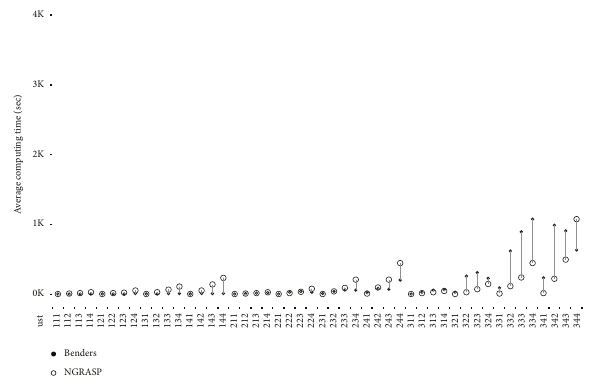
Figure 5: Average computational time on 16-node networks.